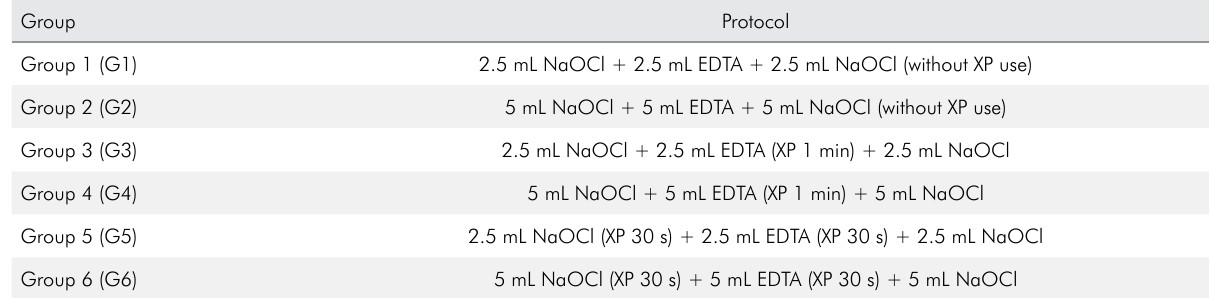
Table 1. Experimental groups